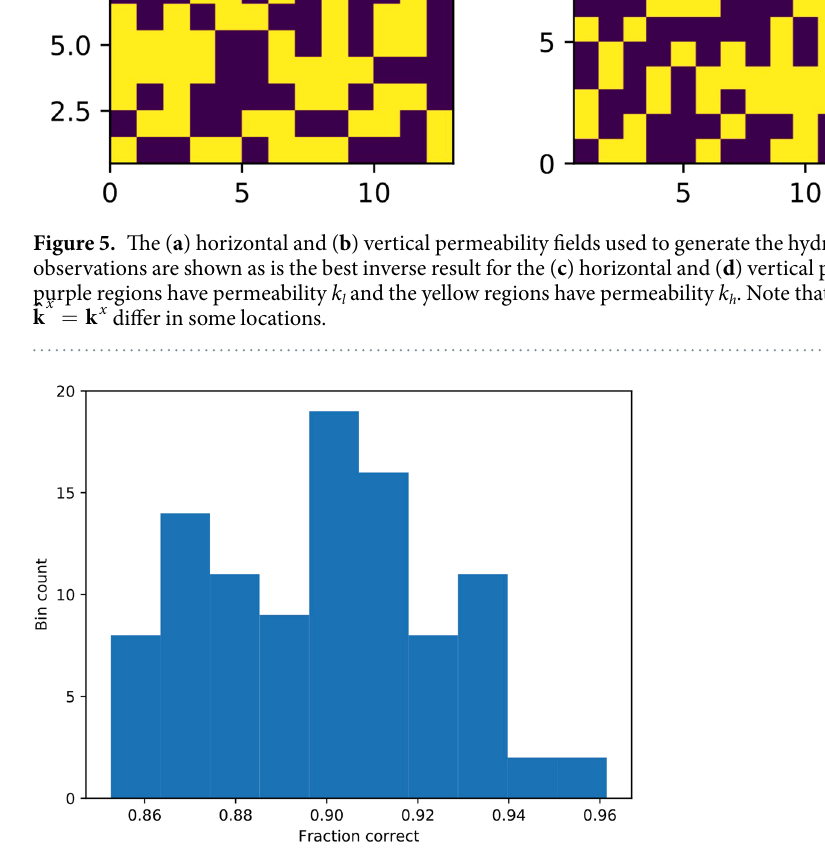
Figure 6. A histogram of the fraction of k shown. Note that in all 100 cases, all of the k